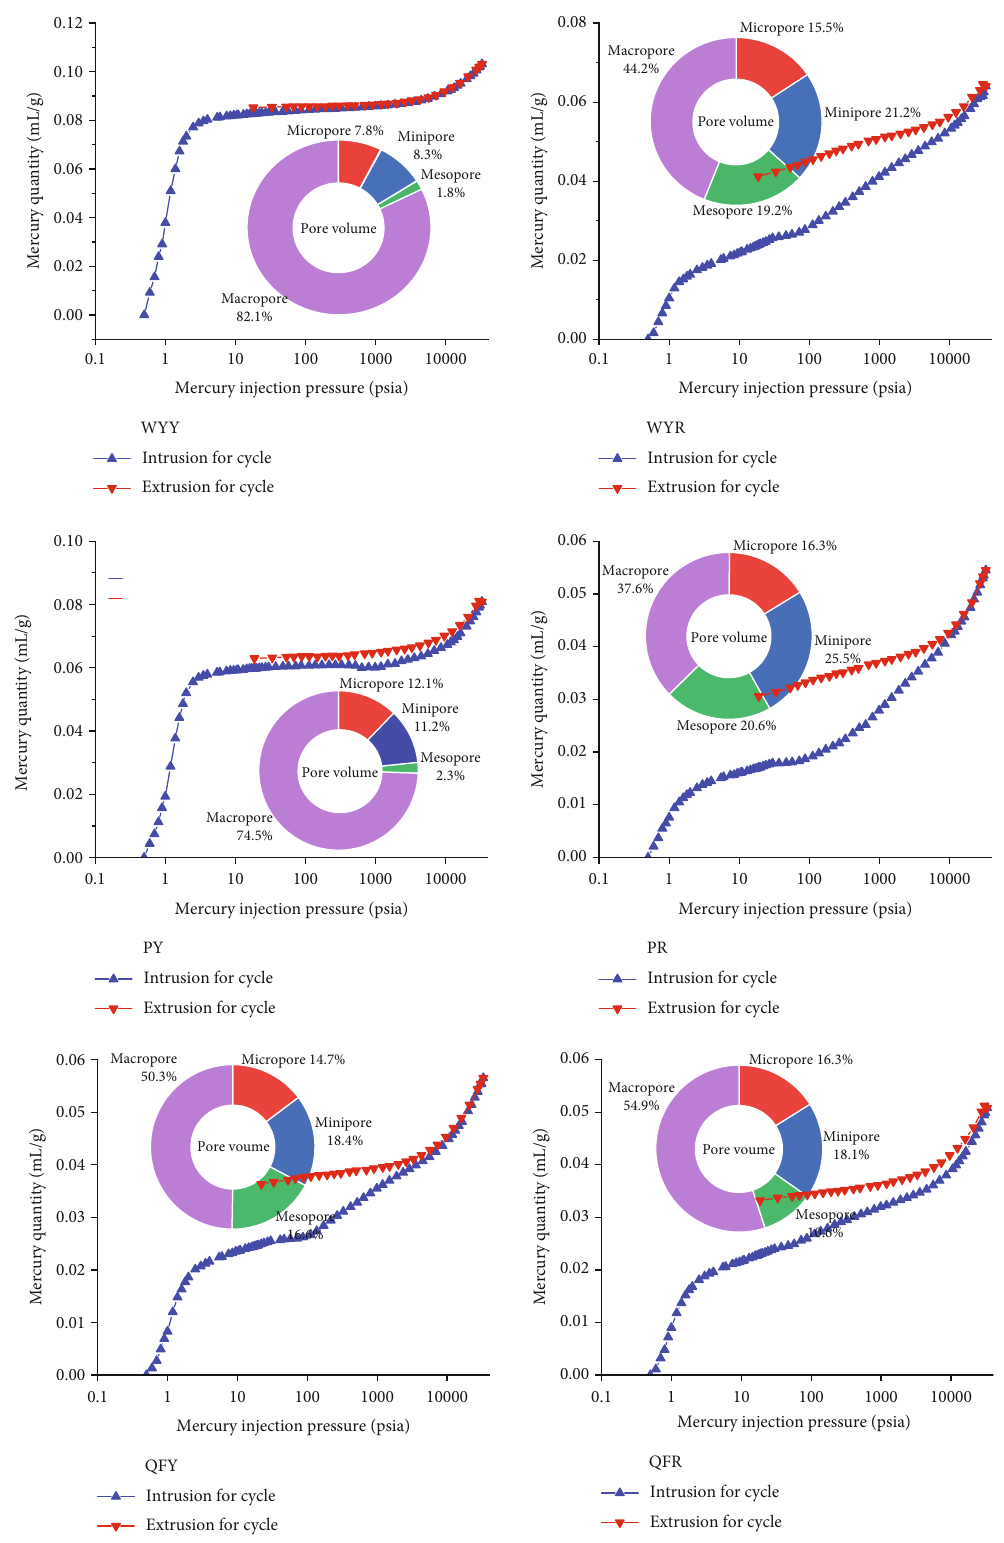
Figure 2: Mercury injection curves of coal